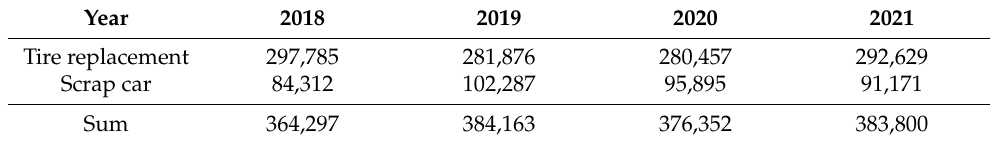
Table 1. The amount (unit: ton) of waste tires generated by